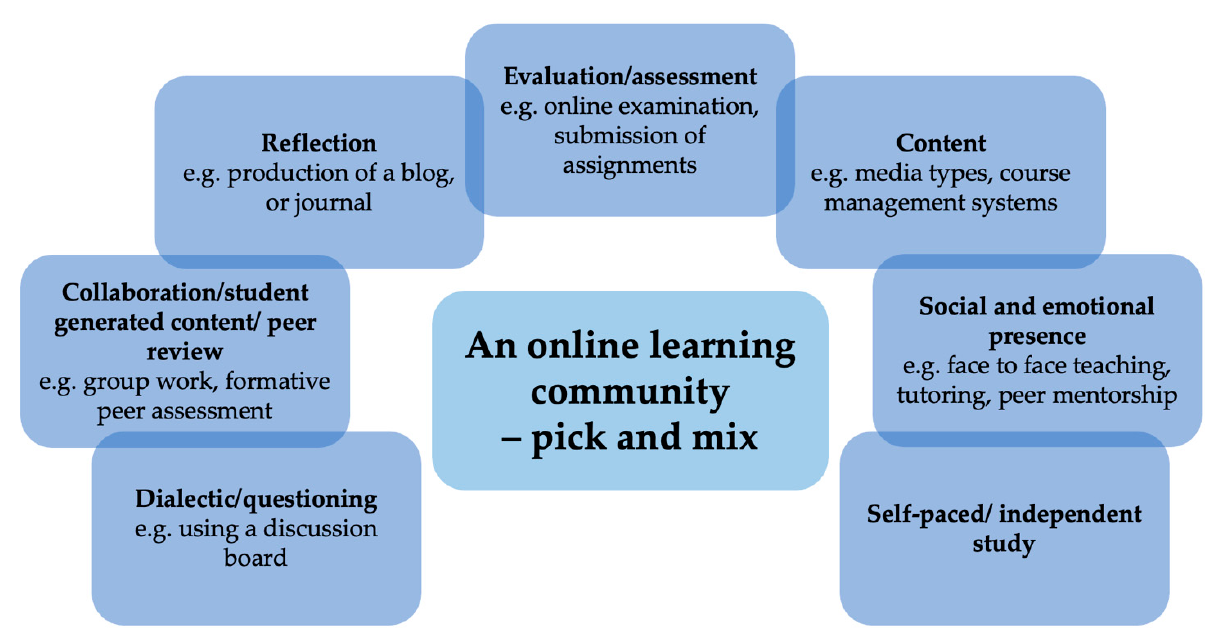
Figure 2. Multimodal Model for Online Education modified from Picciano, (2017) [37].